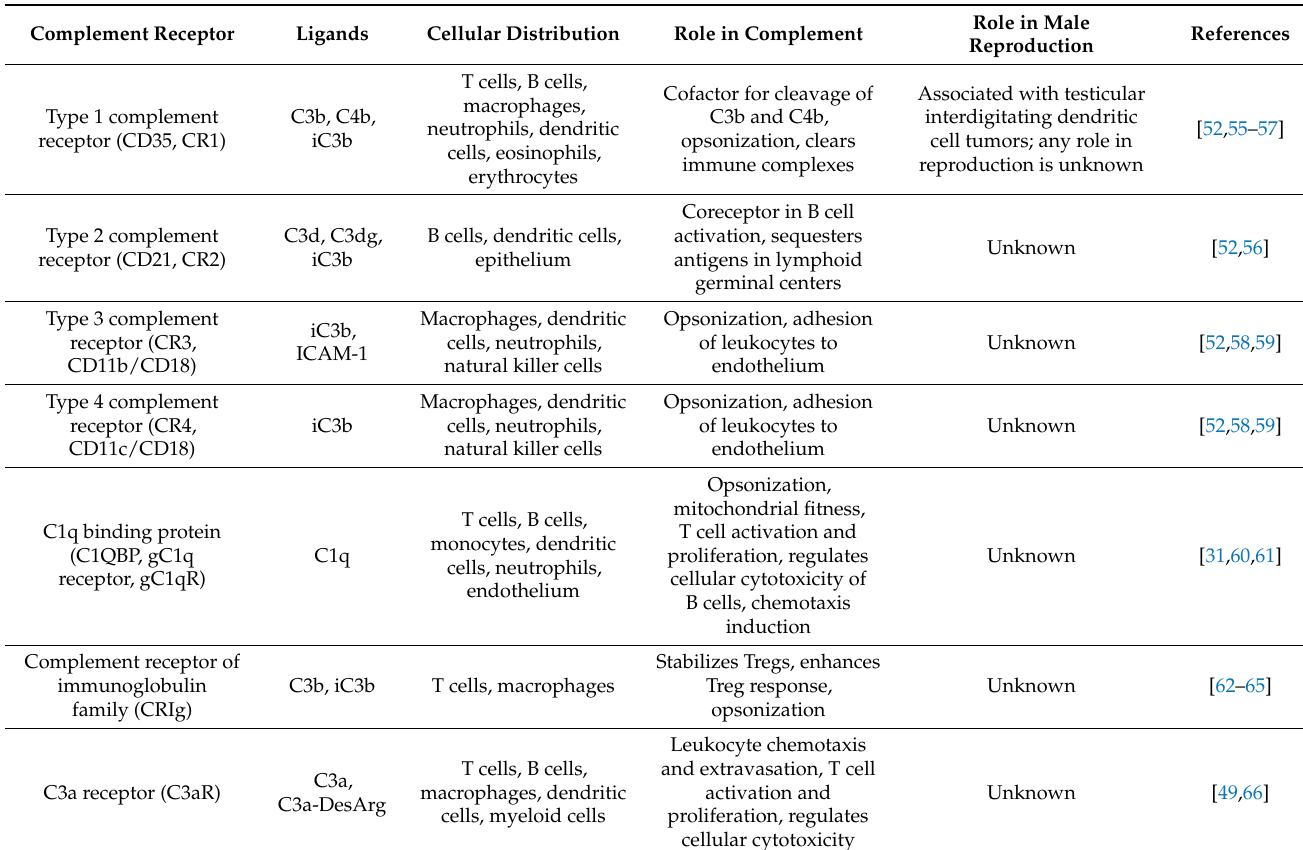
Table 1. Receptors of complement